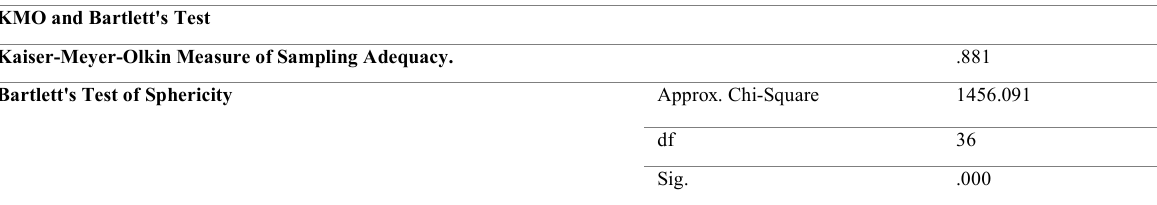
Table 5: KMO and Bartlett's Test for Audit Committee